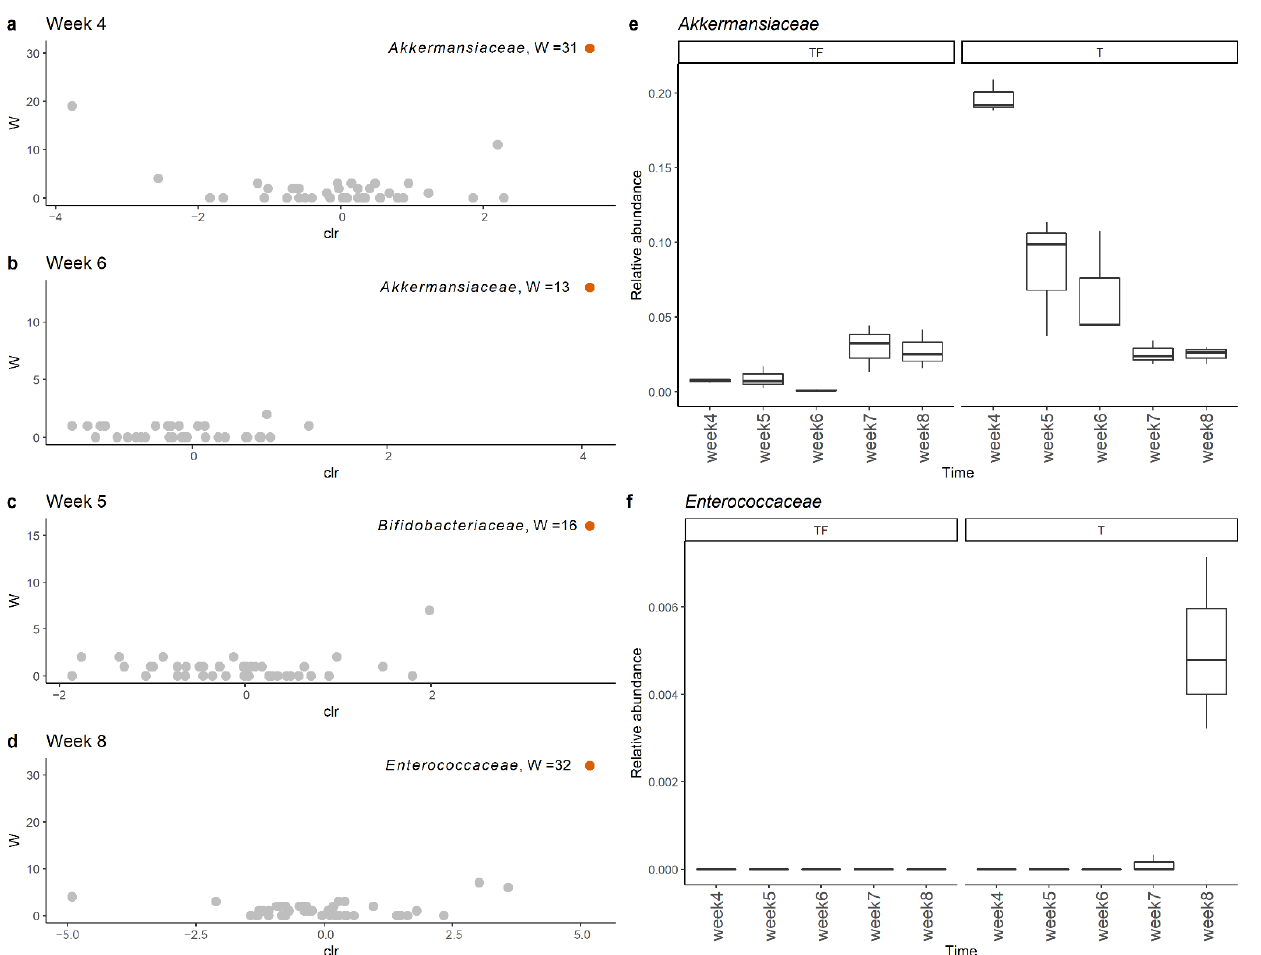
Figure 6. Comparison of microbiota profiles at the family level with ANCOM showed that Akkermansiaceae and Enterocaceae had significantly higher abundance in the T group at ( a ) week 4, ( b ) week 6, ( c ) week 5, and ( d ) week 8. The relative abundance of ( e ) Akkermansiaceae and ( f ) Enterococcaceae family at weeks 4, 5, 6, 7, and 8 in group T and group